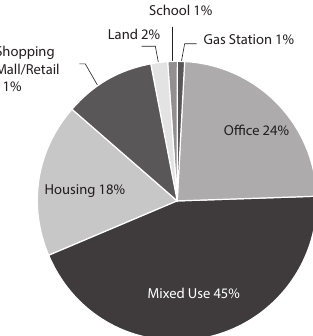
Figure 3. Investment area distribution of the REIFs in